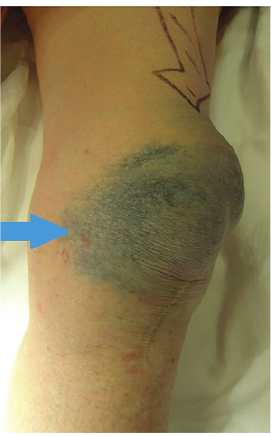
Figure1:Clinicalphotographofthediscolouredsofttissueandlarge effusion secondary to metallosis in the replaced knee.